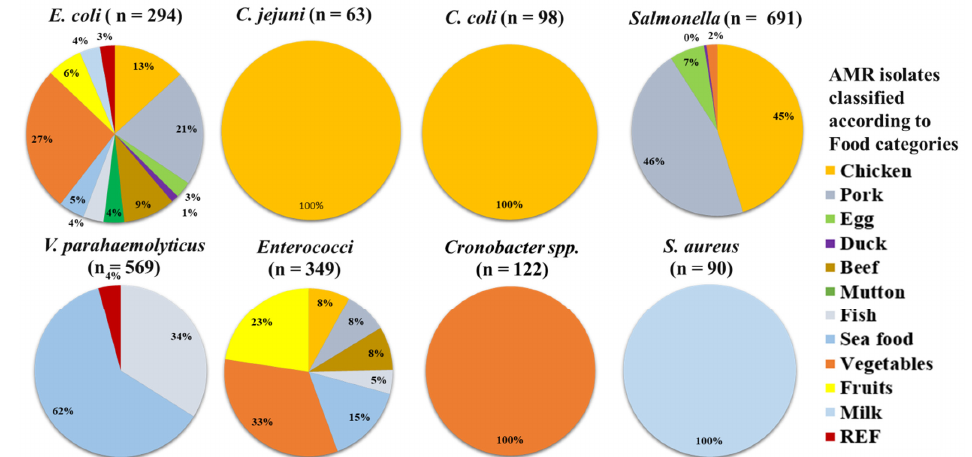
Figure 3. Distribution of the number of food samples in China (n = 2276) that had AMR isolates in them, broken down by food types. In each pie chart, the total at the top indicates the (n) number of samples used to produce the graph.